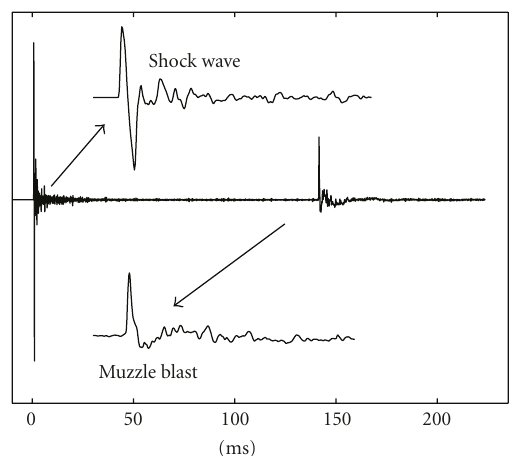
Figure 1: Signal from a microphone placed 180 m from a firing gun. Initial bullet speed is 767m/s. The bullet passes the microphone at a distance of 30 m. The shockwave from the supersonic bullet reaches the microphone before the muzzle